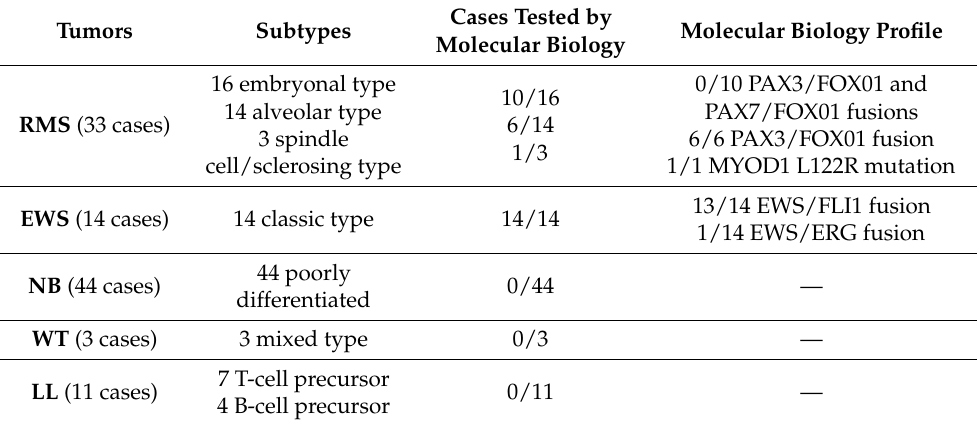
Table 1. Histotypes and molecular biology